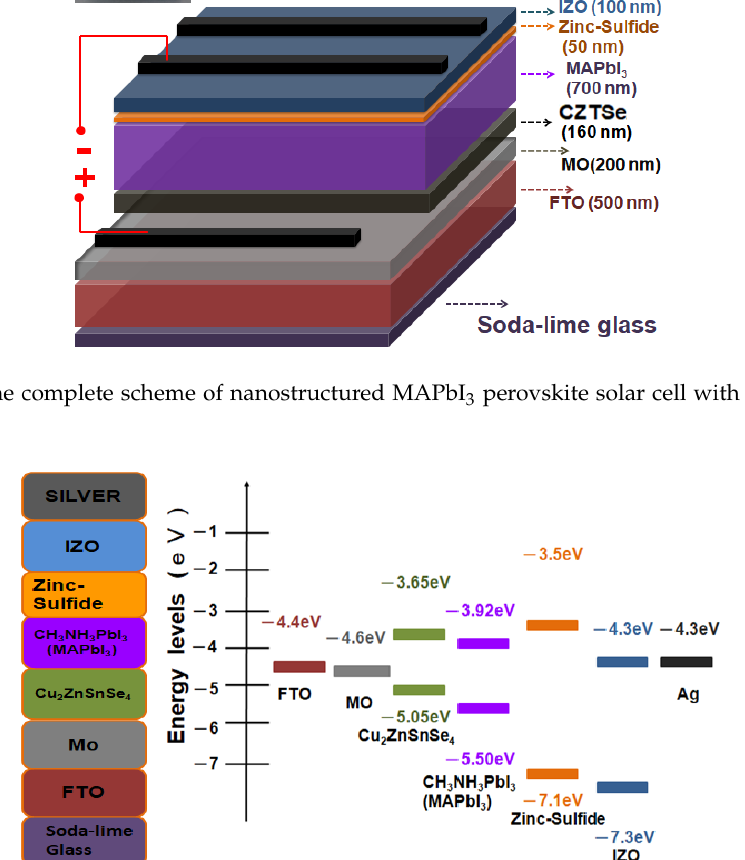
Figure 2. The corresponding energy levels of the planar architecture device of Ag / IZO / ZnS / MAPbI Cu 2 ZnSnSe 4 / Mo /